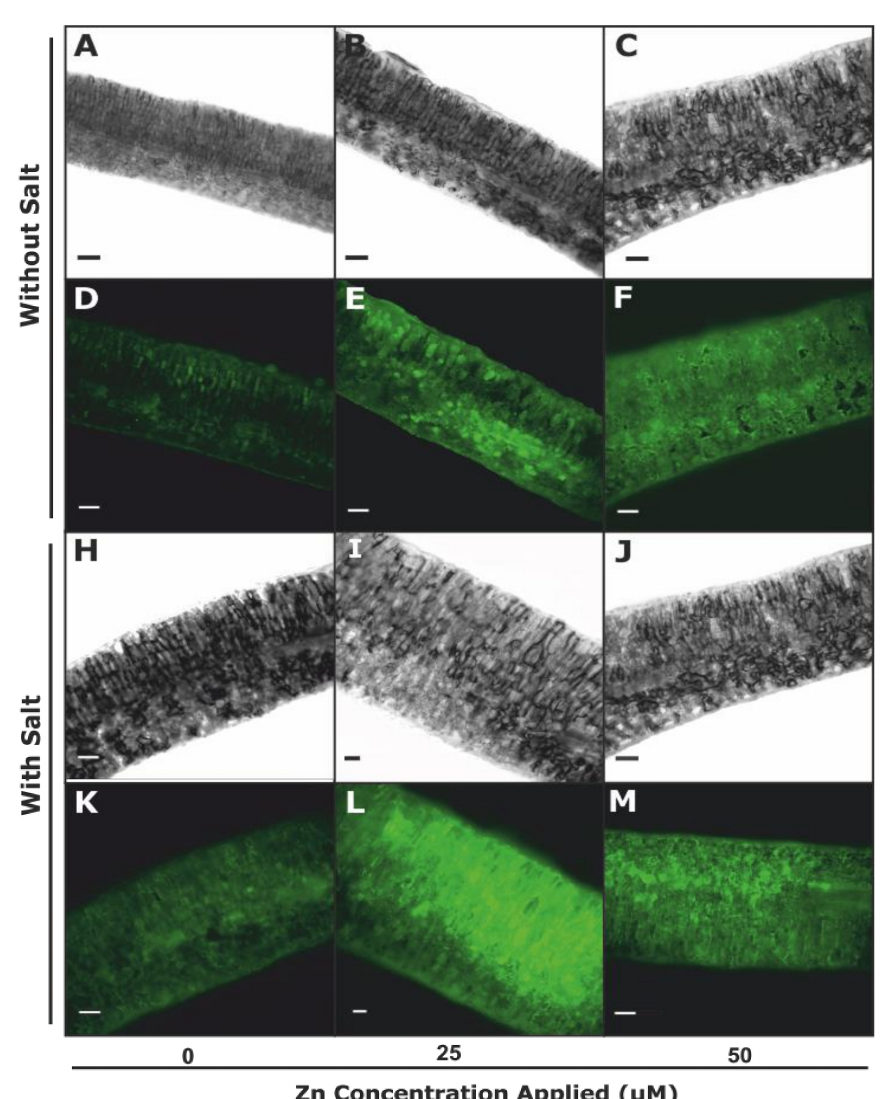
Figure 5. Zinc-pyr-1 staining from transversal leaves sections of pak choi. Green fluorescence indicates area is Zn free. ( A – C ) optical view of leaves sections without salinity condition with Zn application. ( D – F ) fluorescent view of pak choi leaves sections after Zn foliar application under control conditions. ( H – J ) optical view of leaves sections under salinity condition with Zn application. ( K – M ) fluorescent view of pak choi leaves sections after Zn foliar application under salinity conditions. Scale bars correspond to 100 µ m ( A – M